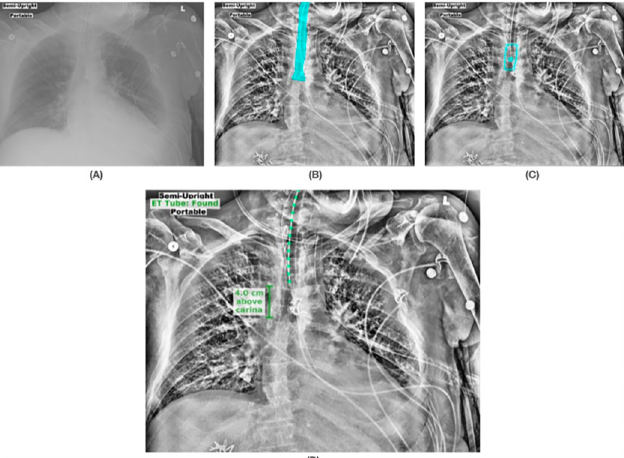
Fig 8. Visualizations of the nodes involved in the knowledge-supported machine reasoning to determine correct ETT placement. (A) Original chest x-ray image; (B) trachea region overlayed on an enhanced image; (C) ETT safe zone ( et_zone ) and tube tip location ( et_tip ) showing the tip within the safe zone; (D) the final output of the system as presented to the physician with the green overlay indicating the system determination of correct tube placement.